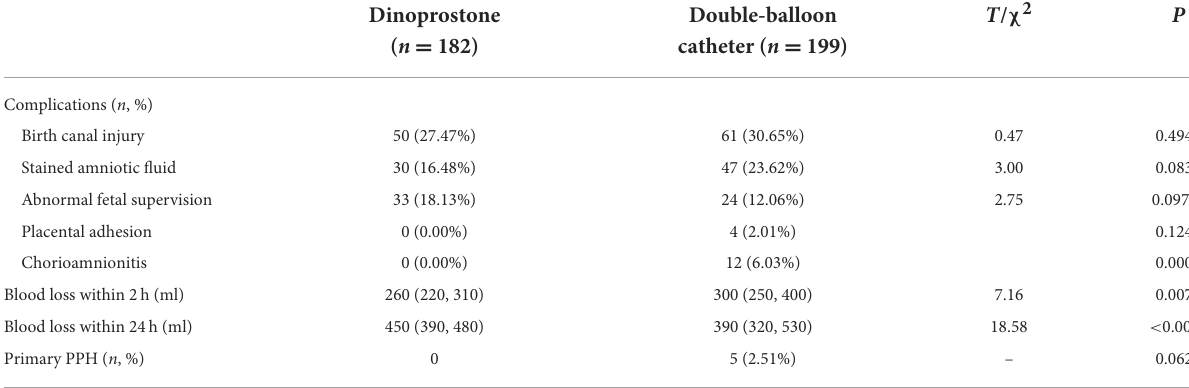
TABLE 4 Maternal outcome and complications during labor